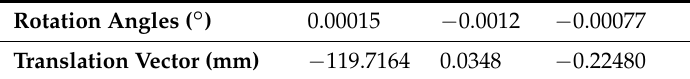
Table 5. External parameters of the left camera and right camera